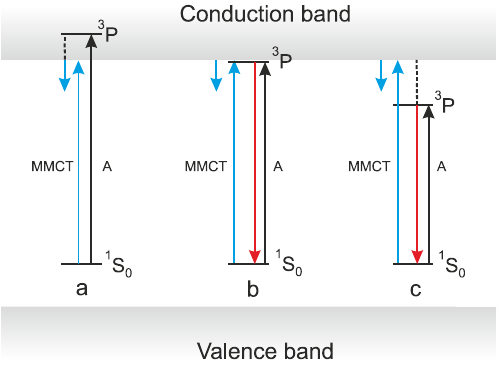
+ -doped compounds proposed in